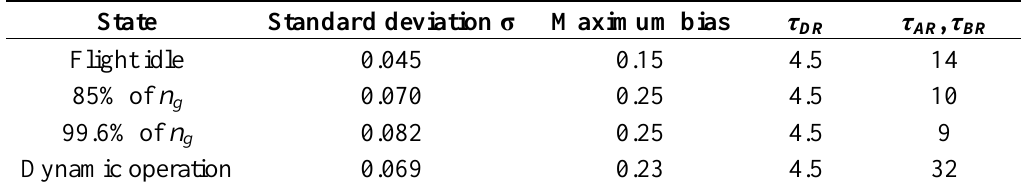
for the turbo-shaft engine. g